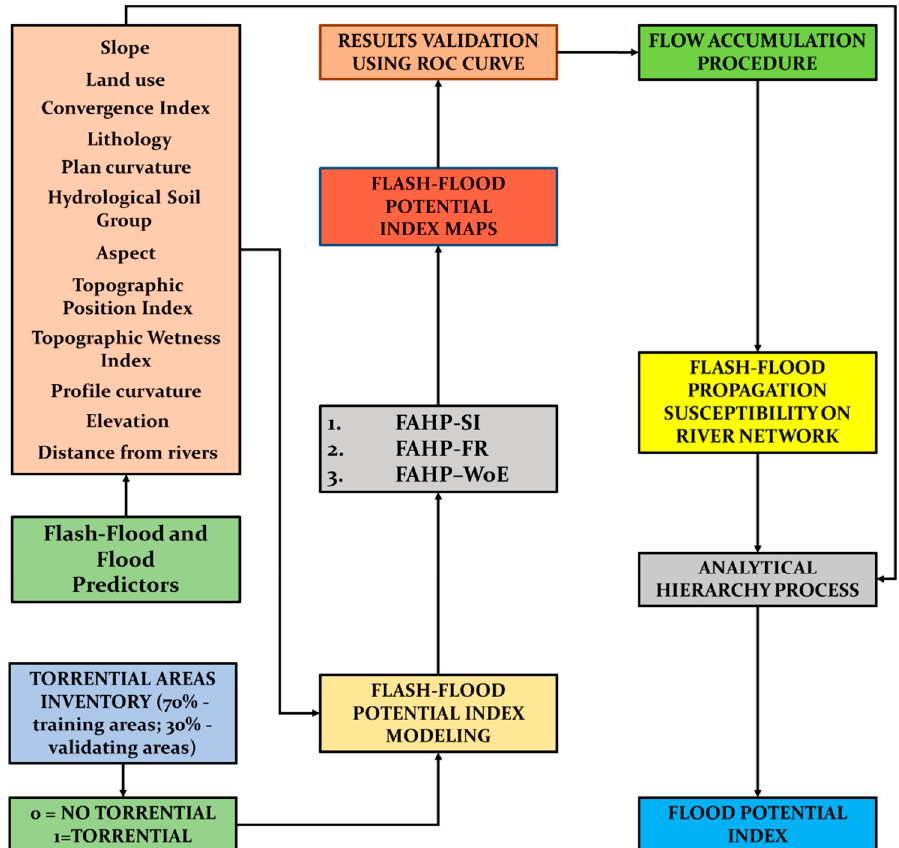
Figure 5. Flowchart of the present